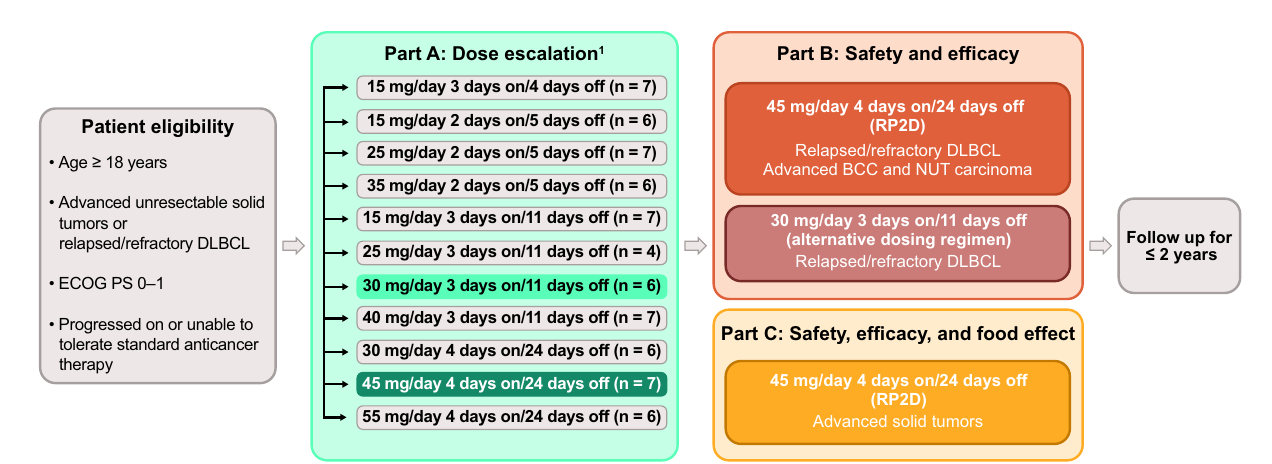
errorbars indicate mean±SD. Source data are providedas a source data fi le. a Data notshownforonepatientwithapercentageofbaseline CCR1 expressionof1110.93; SD for this time point was 260.36. CCR1 C-C motif chemokine receptor 1, mRNA messenger RNA.